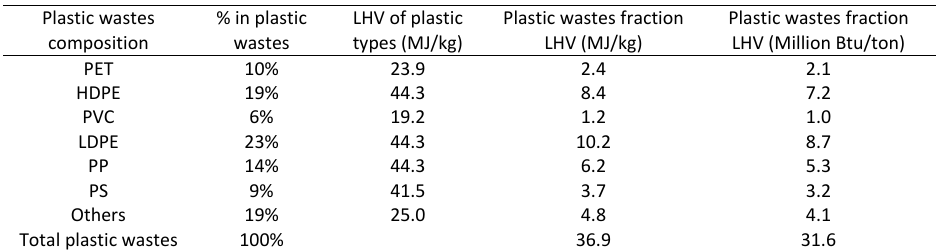
Table 4: Typical MSW plastic wastes composition (Bodzay and Banhegyi, 2016; Themelis and Mussche, 2014)